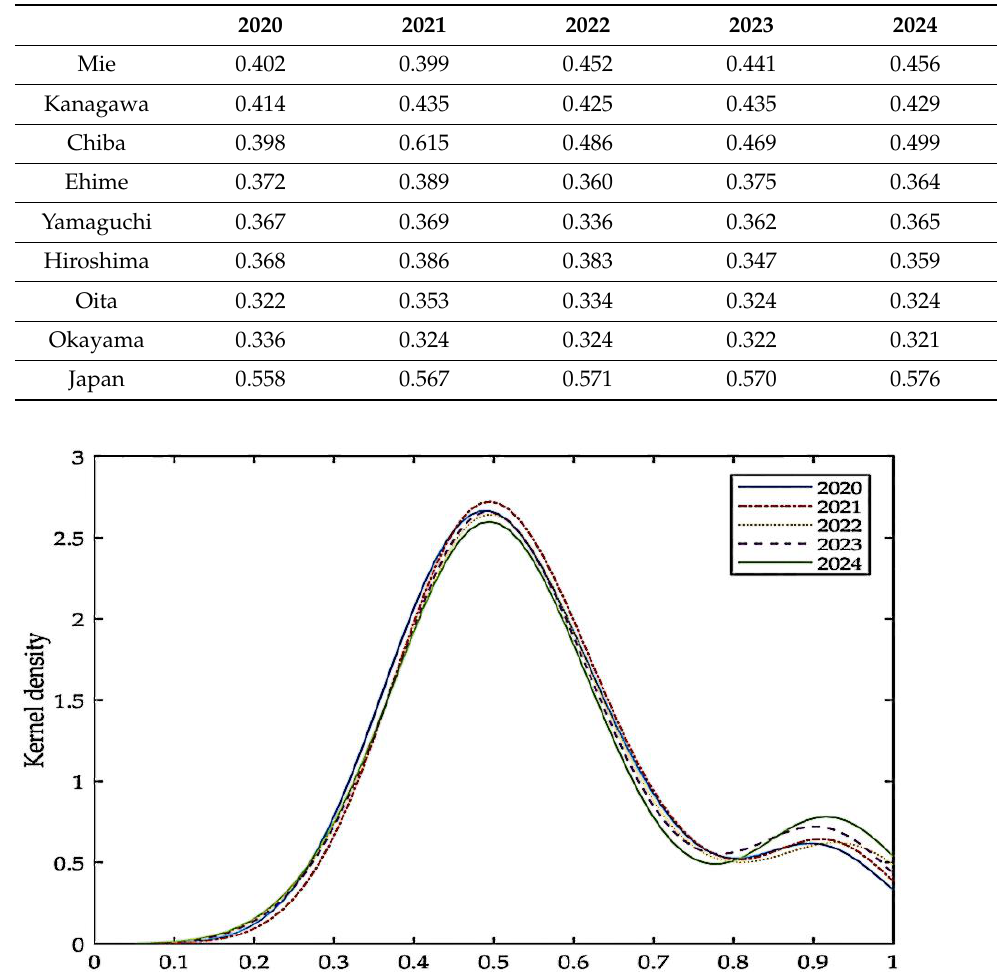
Figure 2. Kernel density estimates of low-carbon economic efficiency values in Japan.